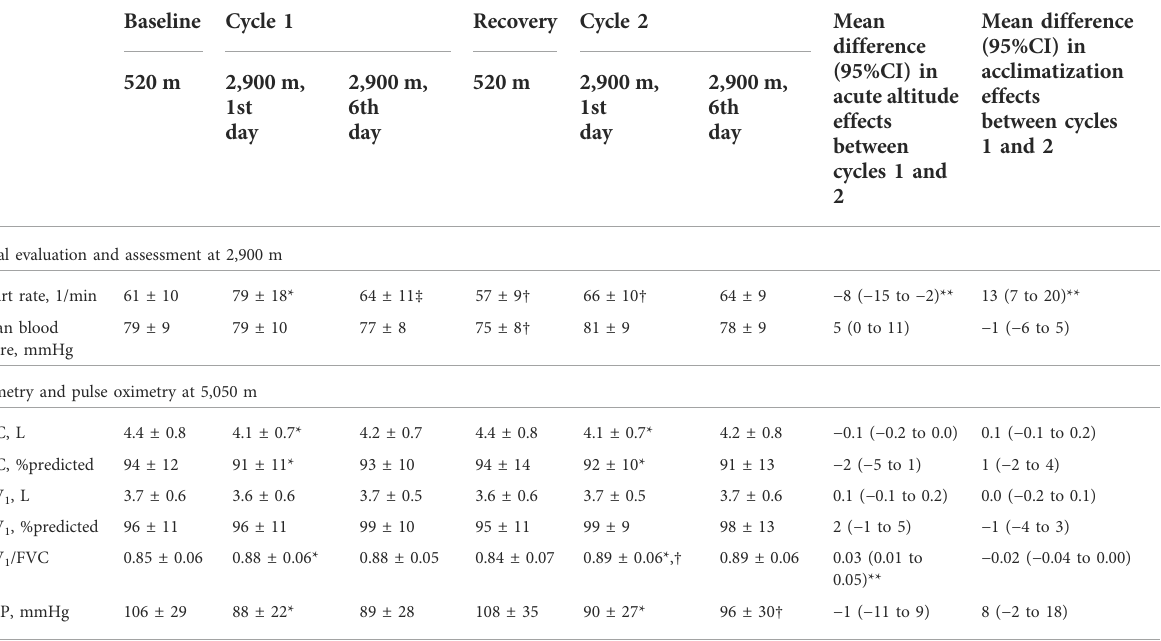
TABLE 3 Daytime assessments at 520 m, 2,900 m and 5,050